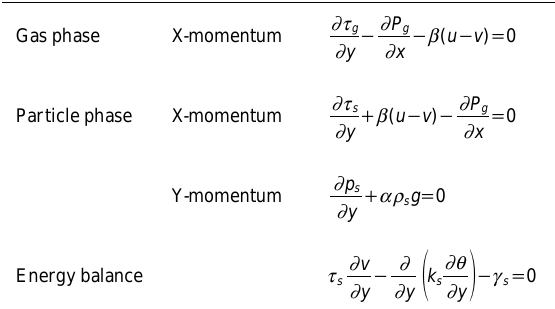
Table 2 Model equations for one-dimensional steady flow in a hor- izontal